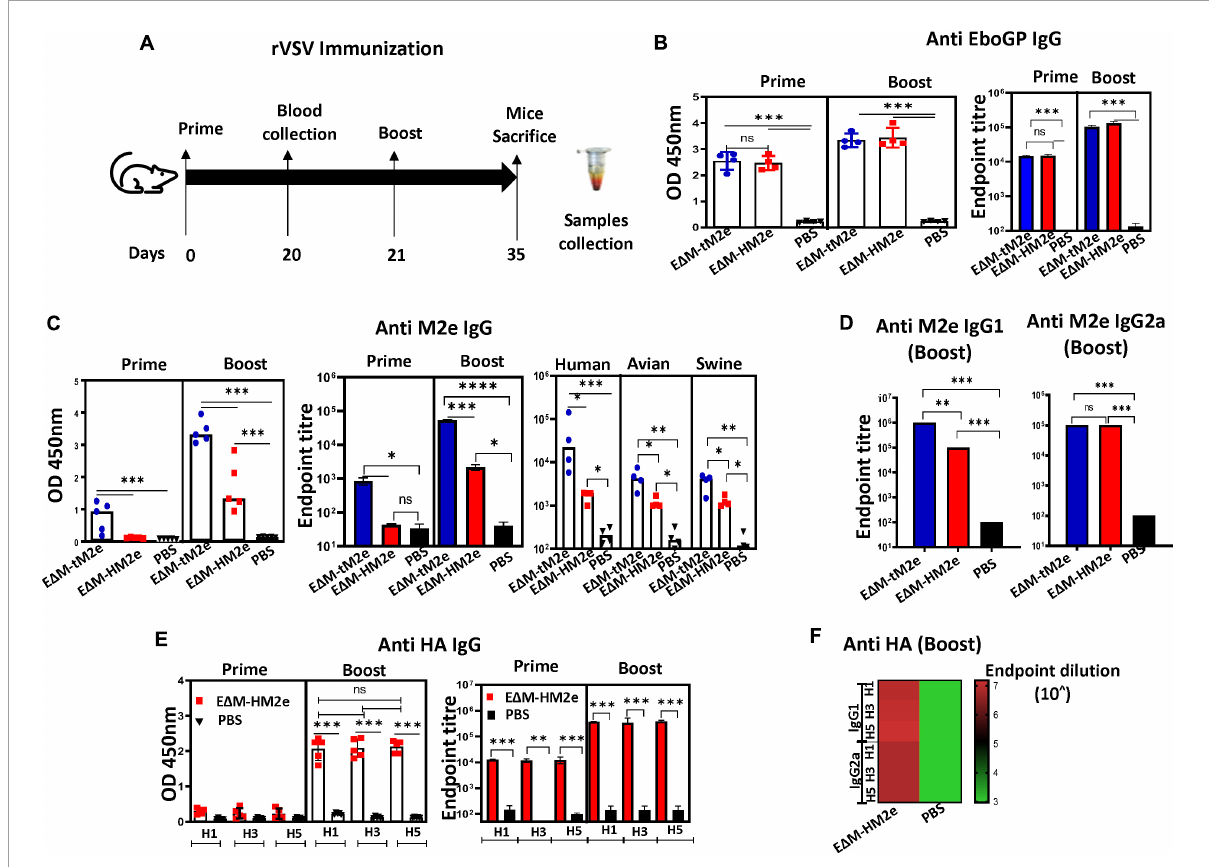
FIGURE4 The specific anti-M2e and anti-HA IgG induced by rVSV-E (cid:49) M-tM2e or rVSV-E (cid:49) M-HM2e in mice sera. (A) The Balb/c mice were injected IM with 1.0 × 10 7 TCID 50 of rVSV-E (cid:49) M -tM2e or rVSV-E (cid:49) M-HM2e on day 0 and 5 × 10 6 TCID 50 on day 21. Serum was collected on days 20 and 35 ( n = 4/5 mice per group). (B) ELISA assay was used to detect the levels of anti-Ebola GP IgG (Left panel: OD 450 nm; Right panel: Endpoint titer). (C) Anti-M2e IgG (Left panel: OD 450 nm; Middle panel: Endpoint titer; Right panel: Test against human, avian, and swine M2e peptides). (D) Anti-M2e IgG1 and IgG2a. (E) Anti-HA (HA1, HA3, and HA5) IgG (Left panel: OD 450 nm; Right panel: Endpoint titer) and anti-HA IgG1 and IgG2a (F) . Statistical significance between the two groups was determined using an unpaired t -test, and significant p -values are represented with asterisks, ∗ ≤ 0.05, ∗∗ ≤ 0.01, ∗∗∗ ≤ 0.001, ∗∗∗∗ ≤ 0.0001. No significance (ns) was